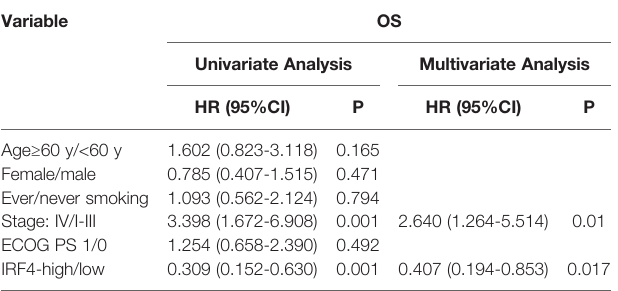
TABLE 1 | Clinical characteristics of lung adenocarcinoma patients. Characteristic All patients (n = 73)